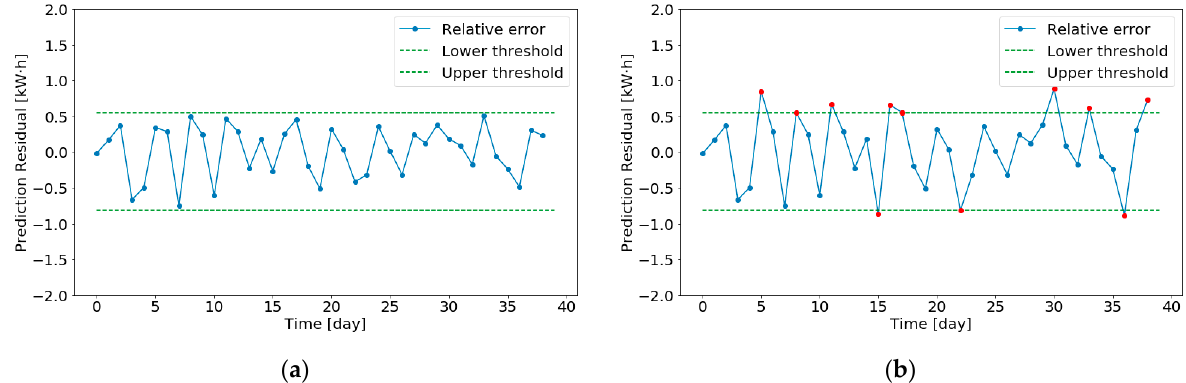
Figure 11. ( a ) The residual output results of the meter 9 in normal state. ( b ) The output result of the residual error of the meter 9 in the 3% error injection model.